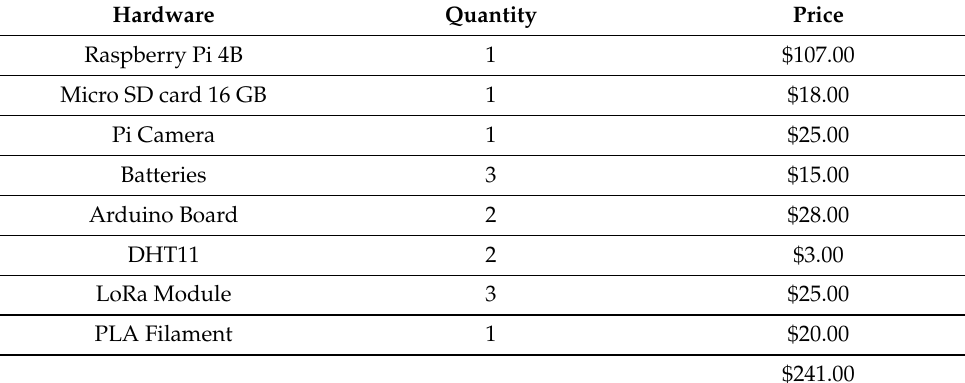
Table 2. List of components and items needed for the development of the